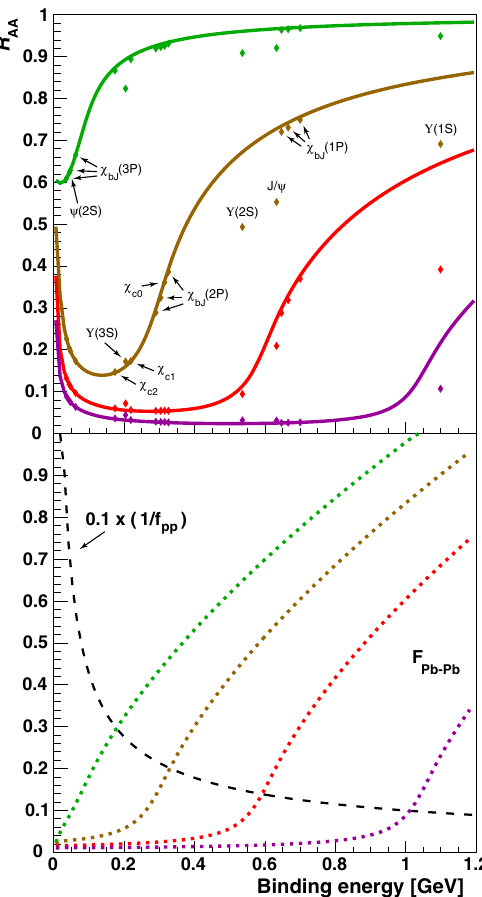
Fig. 3 Top: calculated nuclear suppression factor as a function of the quarkonium E b for direct (curves) and inclusive (markers) production of S- and P-wave states. Results are shown for σ (cid:8) = 30MeV and for (cid:4) (cid:8) (cid:5) = 20, 250, 550 and 1000MeV, respectively shown in green, brown, red and violet. Bottom: individual contributions (Eq. 4) of the long- ψ/Υ distance bound-state transition functions in pp (1 / f pp , scaled by 0.1) ψ/Υ , for the same σ (cid:8) and (cid:4) (cid:8) (cid:5) and Pb–Pb ( F PbPb